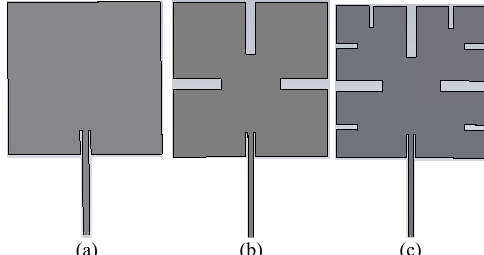
Figure 2: The Scheme of Minkowski fractal iteration of planar structure (a) Initiator(0th iteration) (b) 1st iteration (c) 2nd